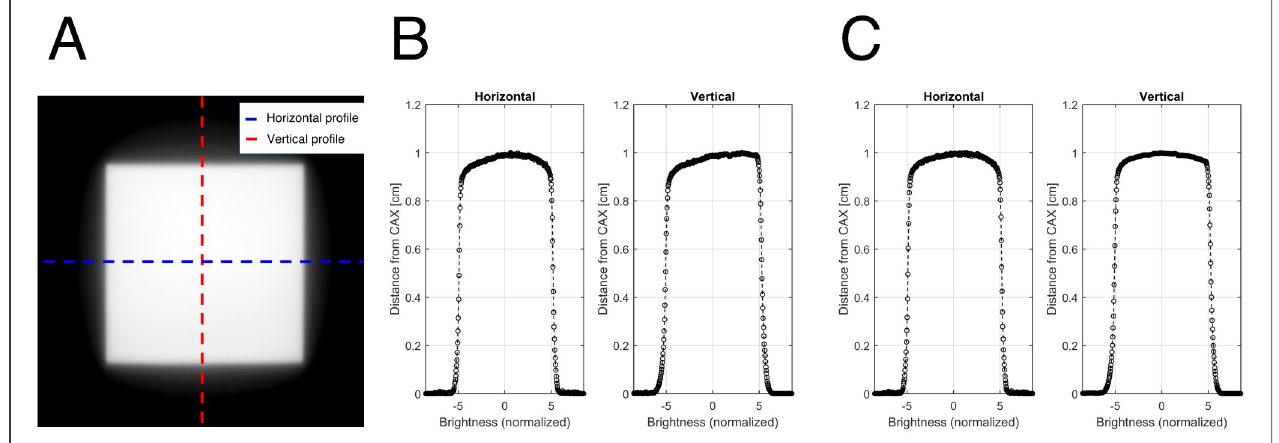
Fig 10. Procedure for brightness dependency by distance: (A) Cumulative two-dimensional scintillation distribution, (B) profiles before the light-intensity correction, and (C) profiles after the light-intensity